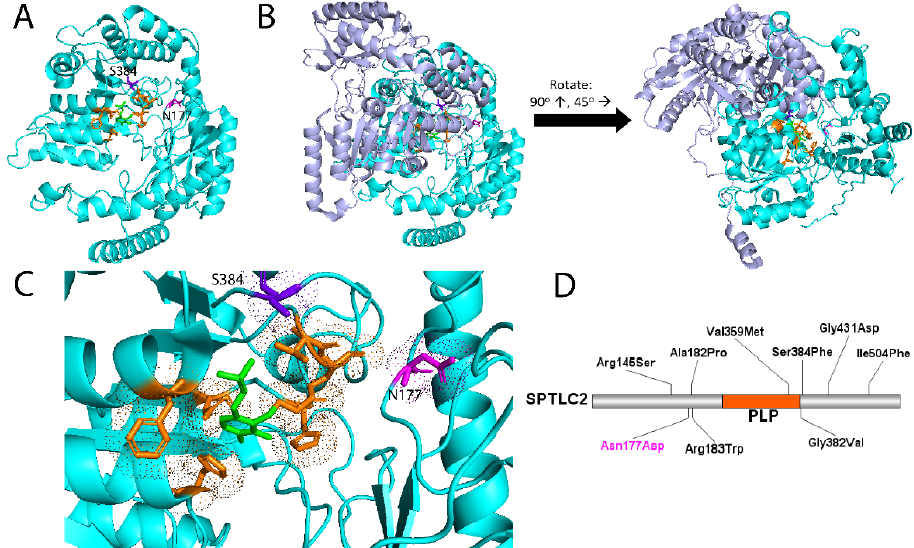
Figure 2. Serine palmitoyltransferase long-chain base subunit 2 (SPTLC2) molecular modeling and mutational analysis. ( A ) SPTLC2 protein (cyan) showing the proximity of the Asn177 residue (magenta) to the active site (orange). This residue is altered in the proband’s family. The only other mutation of SPTLC2 with HSAN1/MacTel2 overlap in the literature, located at Ser384, is notated for comparison (dark purple). PLP cofactor is green. SPTLC2 exists as a single isoform 562 residues in length [10]. ( B ) SPTLC2 (cyan) bound to serine palmitoyltransferase long-chain base subunit 1 (SPTLC1) (purple) to show that the active site (orange) is con fi ned to the SPTLC2 subunit and not at the interface. The view is rotated upwards 90 degrees and left 45 degrees for be tt er visualization of the active site. ( C ) Zoomed in view of ( A ), showing the electron density clouds of the residues involved in the active site (orange), PLP cofactor (green), and residues at the locations of Asn177 and Ser384, the known MacTel2-causing mutations (magenta and dark purple). ( D ) Locations of point mutations in SPTLC2 known to cause HSAN1. Highlighted in orange is the pyridoxal 5 ′ -phos- phate binding pocket (labeled “PLP”) and presumed active site. The proband family’s mutation is shown in magenta.